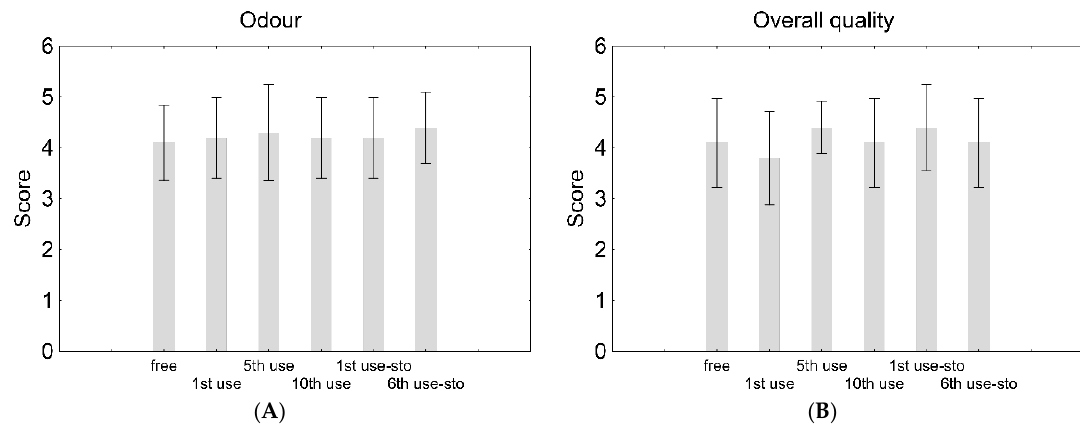
Figure 4. Results for the sensory scores (odor and overall acceptability) (mean ± standard deviation). Free, cider produced with free S. cerevisiae ; 1st, 5th, and 10th use: cider from experiment A ( A ) with apple pieces used 1, 5, or 10 times; 1st use-sto and 6th use-sto: experiment B ( B ) (apple pieces stored at 4 °C for 7 days before their use) pieces used 1 or 6 times. The samples were not significantly different ( p > 0.05, Friedman